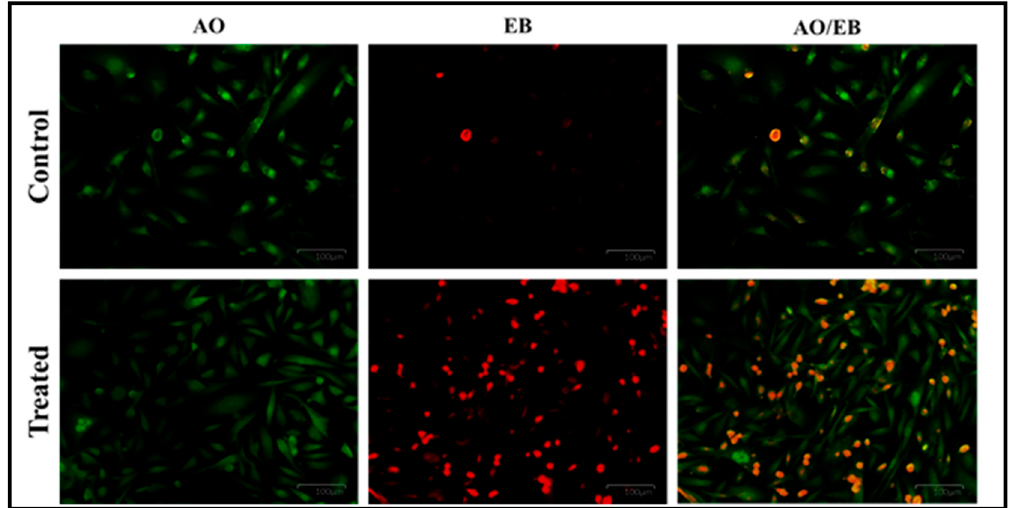
Figure 11. AO/EB dual staining apoptotic assay.